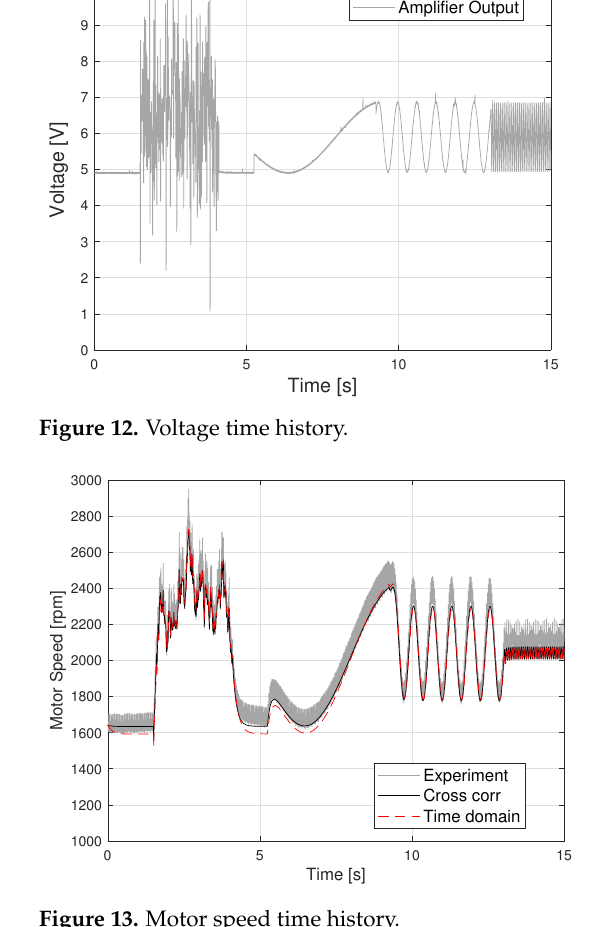
Figure 13. Motor speed time